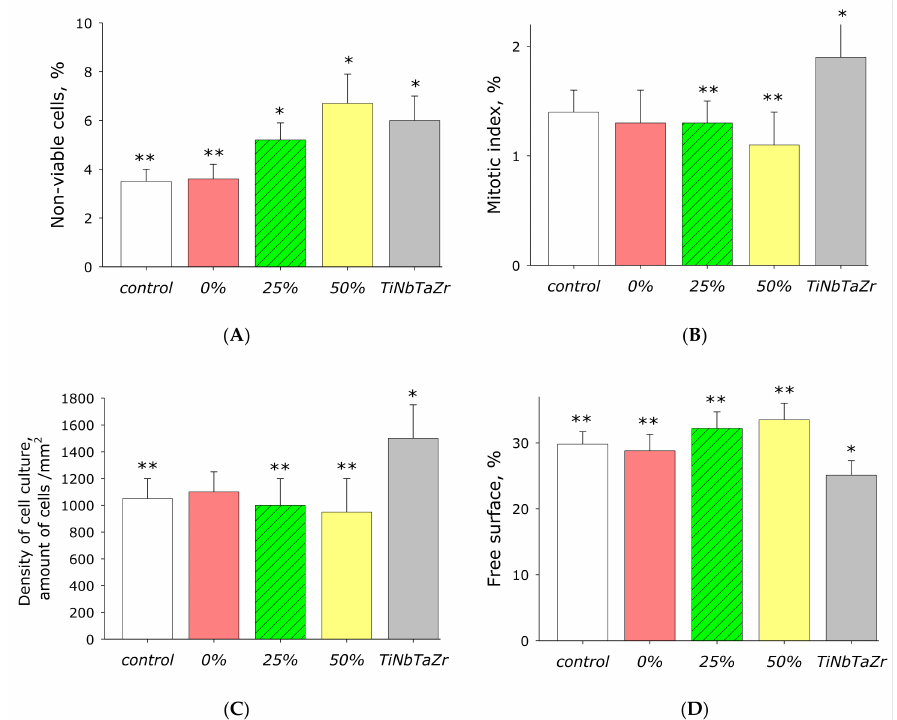
Figure 15. The effect of material AP-ZnO on the main characteristics of the growth and development of cell cultures. ( A ) Effect of material AP-ZnO on cell viability. ( B ) Effect of material AP-ZnO on the mitotic index of the cell. ( C ) Effect of material AP-ZnO on cell culture density. ( D ) Effect of material AP-ZnO on the rate of colonization of the available area. TiNbTaZr is a medical alloy based on the elements titanium, niobium, tantalum, and zirconium. * indicates a significant difference at 5% level in comparison with the control ( p < 0.05). ** indicates a significant difference at 5% level in comparison with the group TiNbTaZr ( p <